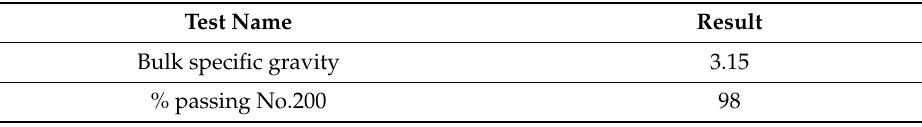
Table 3. Cement mineral filler physical properties.